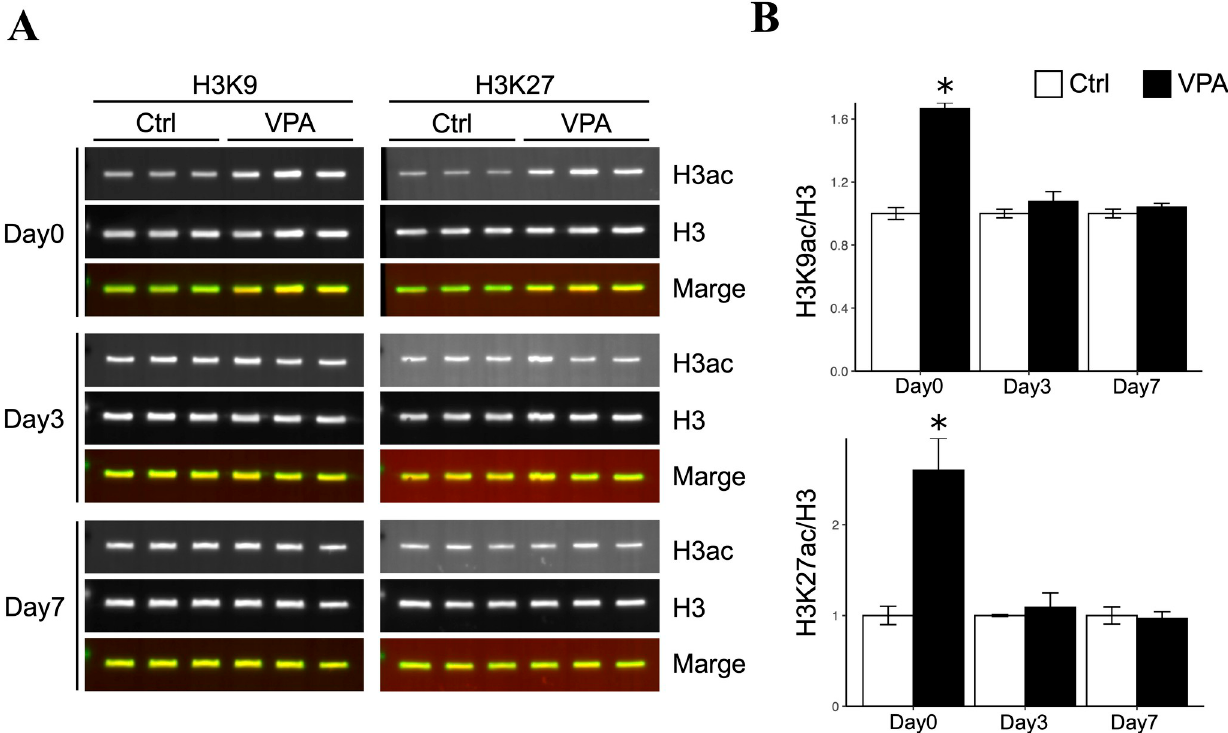
Fig 1. Testicular histone acetylation levels determined using multiplex fluorescent western blotting. (A) All blotting images of the control and VPA- treated groups are depicted. On the left is histone H3K9 and on the right the bands of histone H3K27, and from the top row, immediately after treatment with VPA or saline, 3 days later, 7 days later, the histone acetylation bands, histone H3 bands, merged bands images. Histone acetylation and histone H3 bands images are shown in monochrome. (B) The bars show the fluorescent signals of histone acetylation at each sampling point. The signals are standardized to the histone H3 signal, with value relative to the control group as 1. Data are shown as mean ± S.E. (n = 3, � P < 0.05).